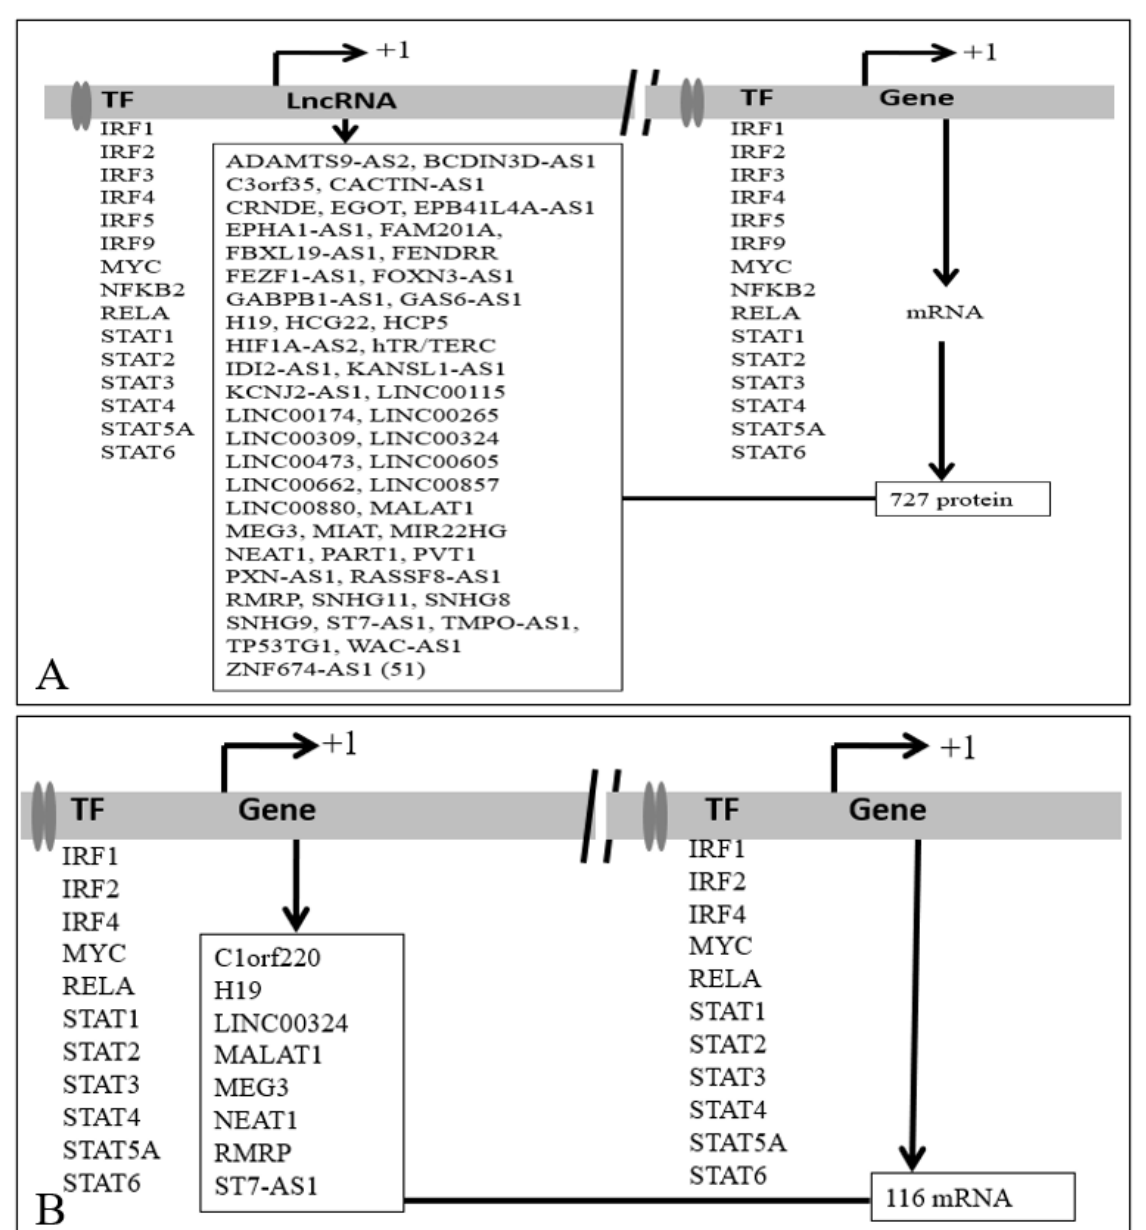
Figure 11. Summary of coregulated 727 PCG by 51 lncRNA (open box) that interacts (horizontal line joining lncRNA (within the box) with genes at protein and 15 TFs shown below DNA (filled rectangle) upstream to genes ( A ). Similarly, 116 mRNA co-regulated by 11 TFs and eight lncRNA. LncRNA and mRNA are regulated by 11 TFs ( B ).